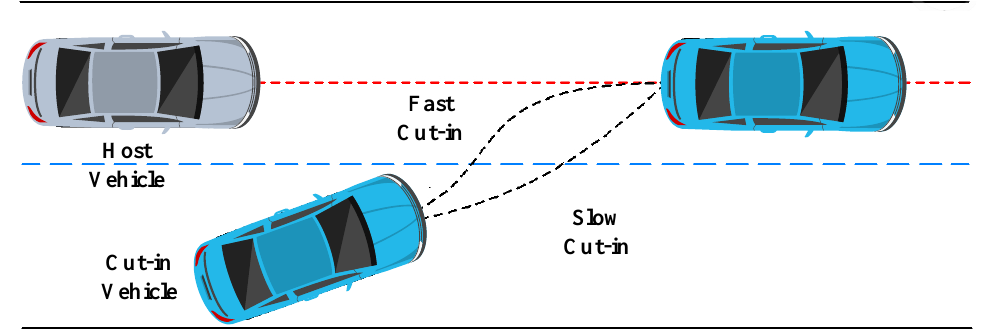
Figure 6. Cut-in behavior of different vehicles. Figure 6. Cut-In behavior of different